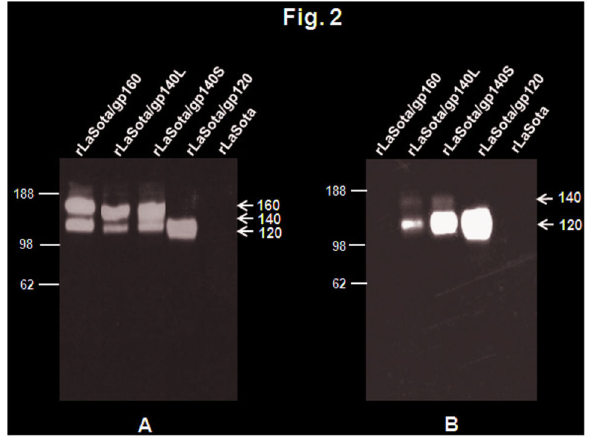
Figure 2. Detection of NDV-expressed Env proteins present in infected-cell lysates (A) and the cell culture medium (B). DF1 cells were infected with indicated viruses at an MOI of 0.01 PFU. After 48 h, the cell culture medium supernatants and cells were collected and processed. (A) The cell lysates were prepared from cells and subjected to SDS- PAGE under reducing conditions. (B) The cell culture medium supernatants were concentrated 10x by passing through Amicon filters and subjected to SDS-PAGE under reducing conditions. The gels were analyzed by Western blotting using a pool of gp120-specific monoclonal antibodies. The positions of HIV-1 gp160, gp140 precursor gp120 are indicated by arrows in the right margin. Molecular masses of marker proteins (in kilodaltons) are shown in the left